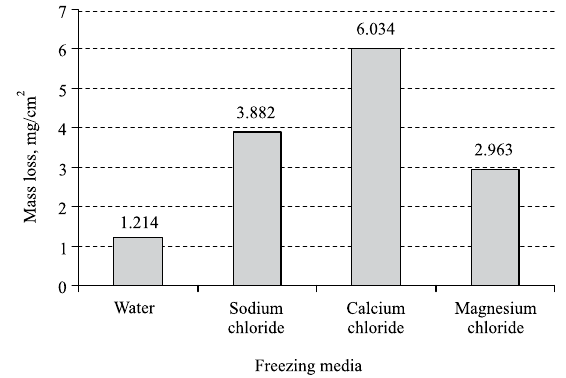
Fig. 7. The dependence of mass loss on saline solution type in specimens with Portland cement after 56 freeze-thaw